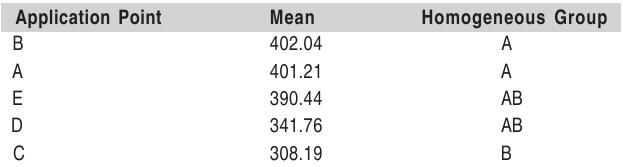
Table 2 – Results of Tukey’s test for the mean microstrain values at five load points.